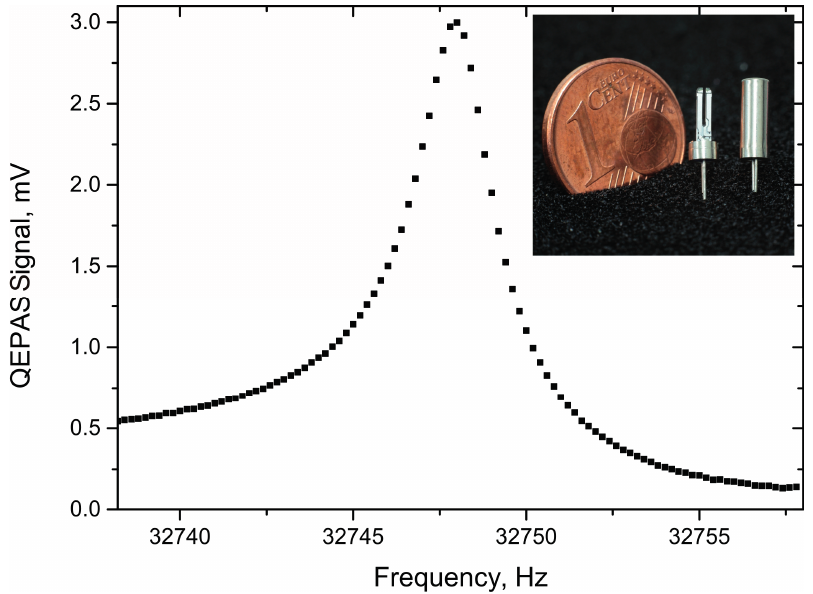
Figure 2. Typical resonance curve of the QTF within the methane QEPAS cell. The inset shows a photograph of a QTF with and without